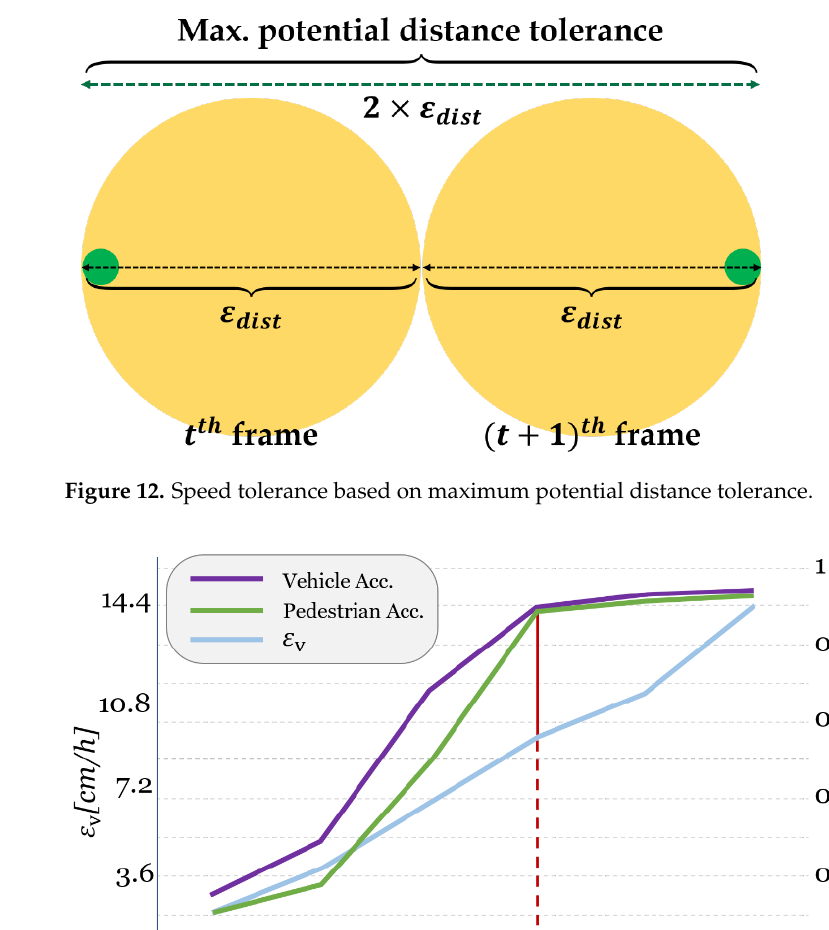
by /. /. 𝜺𝜺 𝒗𝒗 𝜺𝜺 𝒅𝒅𝒅𝒅𝒅𝒅𝒅𝒅 𝜺𝜺 𝒗𝒗 𝜺𝜺 𝒅𝒅𝒅𝒅𝒅𝒅𝒅𝒅